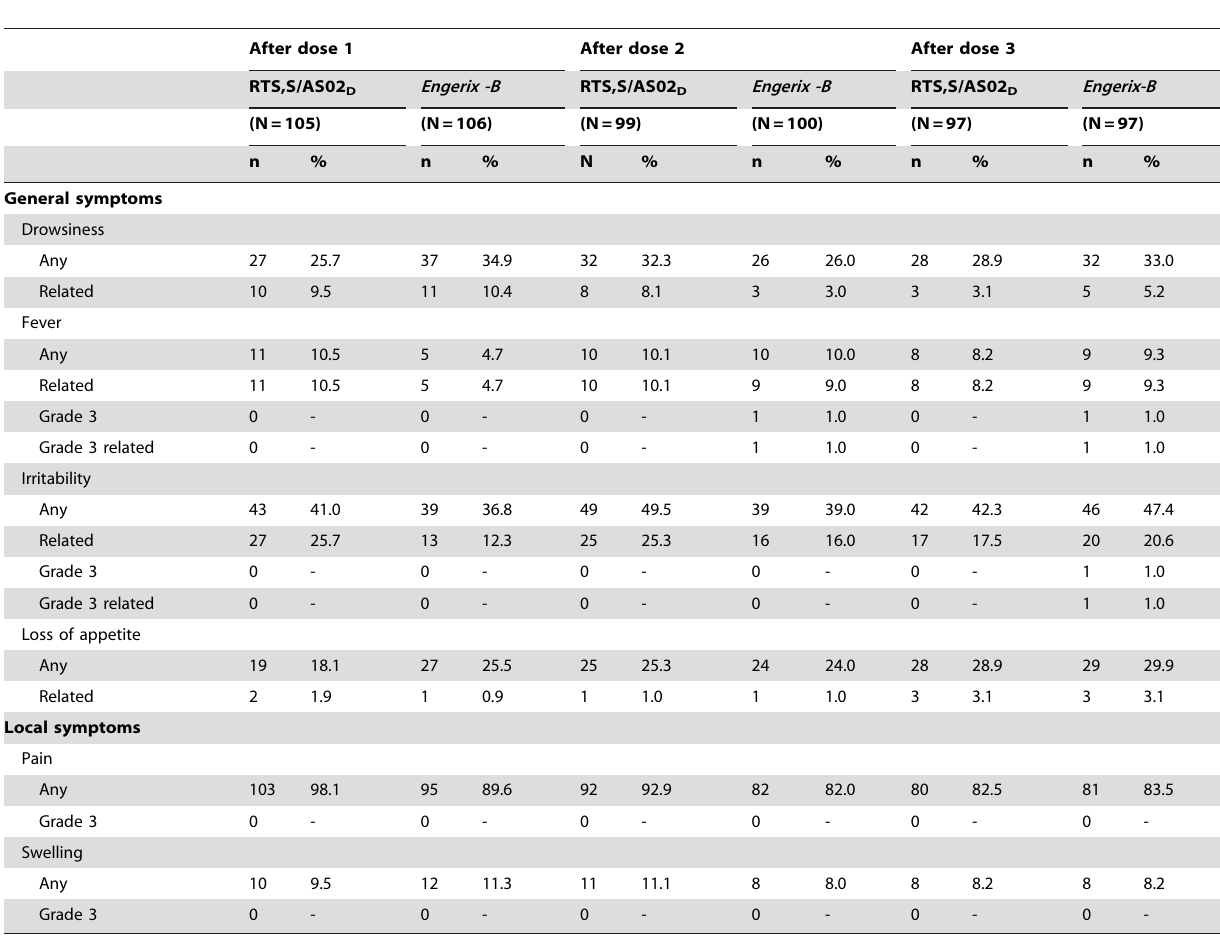
Table 1. Incidence of solicited general symptoms by dose within the 7-day follow-up after RTS,S/AS02 D or Engerix-B TM .